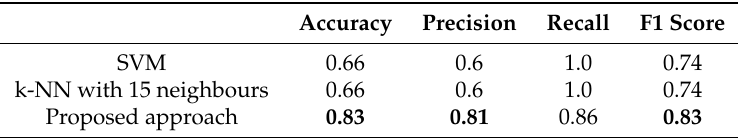
Table 3. Resulting metrics for classical models using